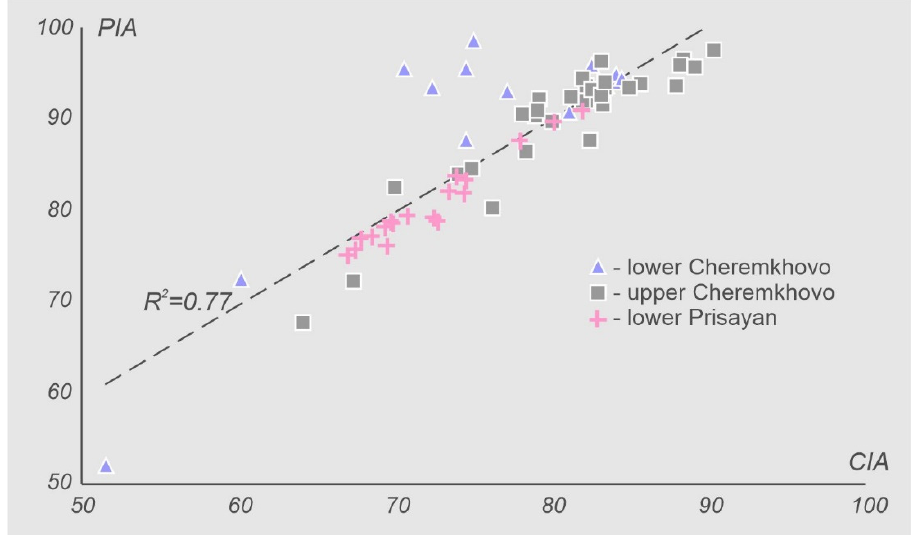
Figure 9. The plot of the chemical index of alteration (CIA) versus the plagioclase index of alteration (PIA).